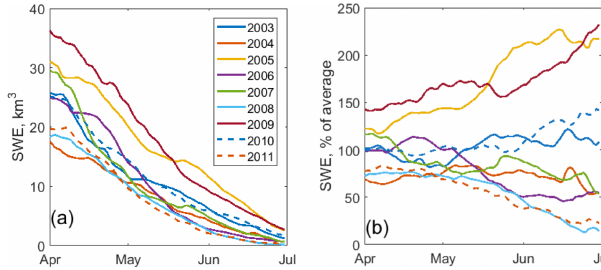
Figure 2. Reconstructed total SWE volume (a) and percent of 2003–2011 average (b) for all non-glacierized pixels in the study